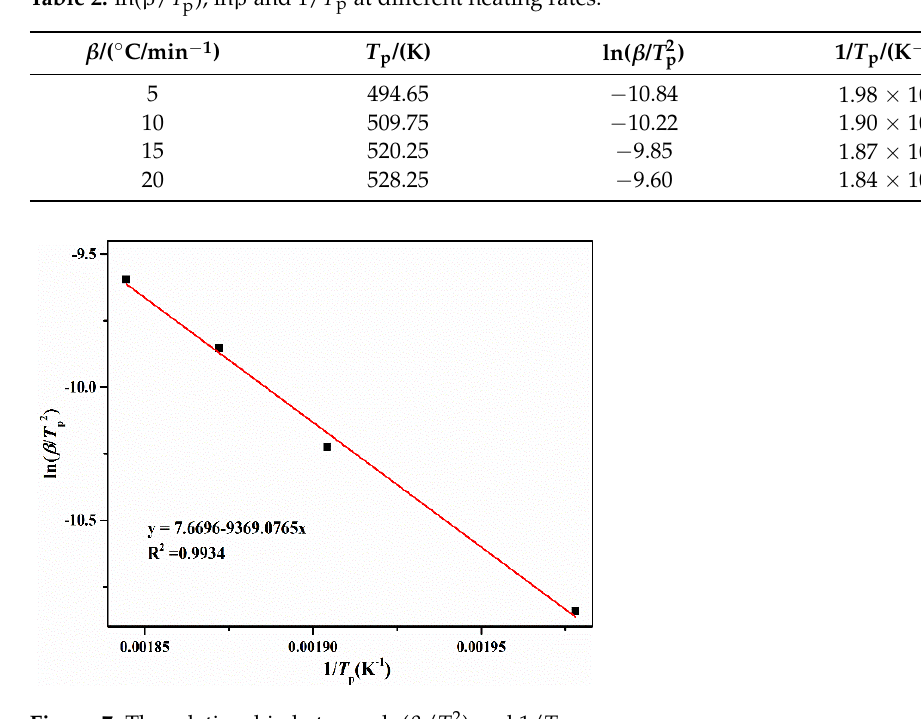
Figure 7. The relationship between ln(β/ T 2